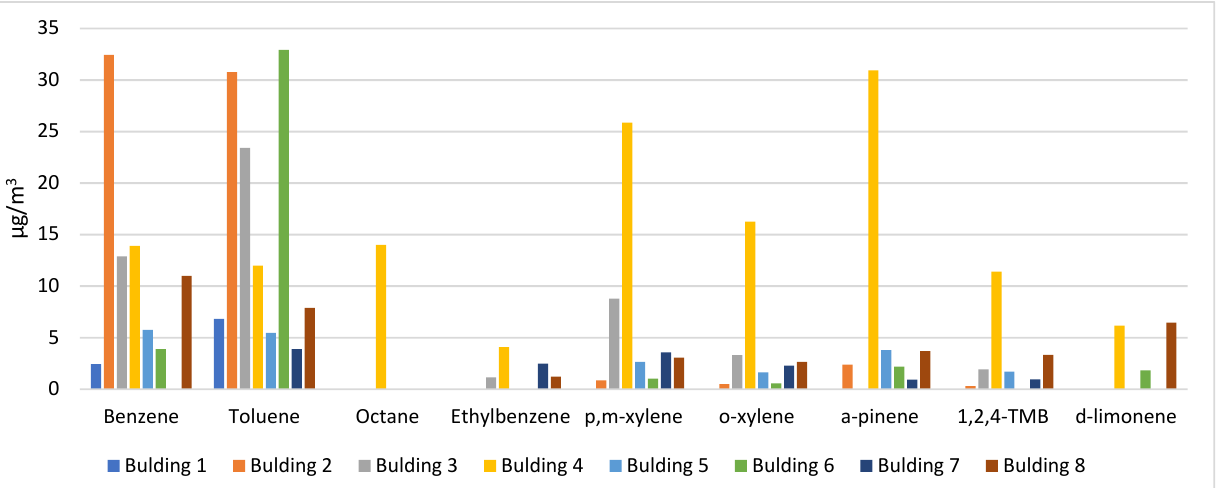
Figure 10. Indoor concentrations (μg m −3 ) of Aldehydes. Figure 11. Indoor concentrations (μg m −3 ) of O 3 , NO 2 and SO 2 . As a first evaluation, the computed median and mean values of pollutant concentra- tions of this study were compared with the relevant seasonal (summer) values reported in the OFFICAIR project [17], a European project in which a wide scale of indoor air pol- lutants measurements in 37 office buildings were performed [58]. Overall, among the